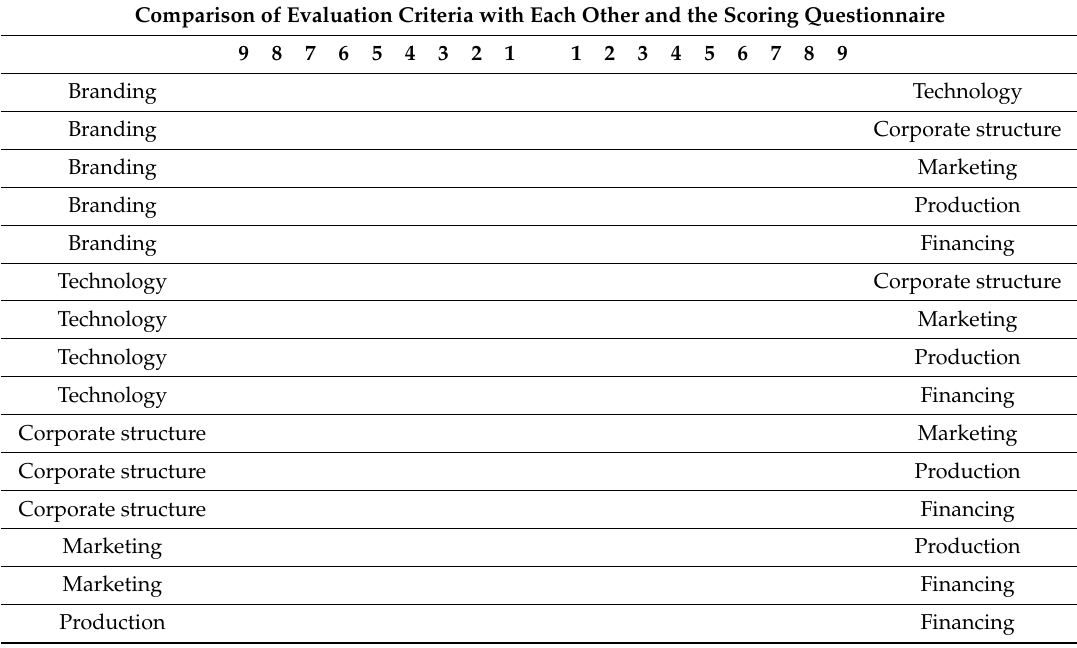
Table 5. Questionnaire table for Analytical Hierarchy Processes (AHP). Comparison of Evaluation Criteria with Each Other and the Scoring Questionnaire